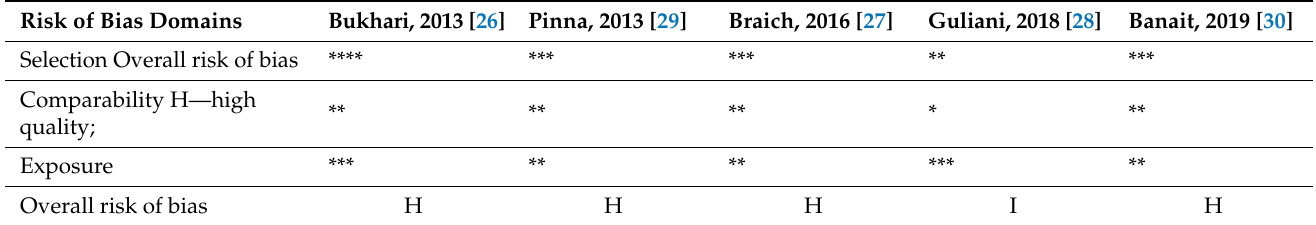
Table 3. Quality of evidence assessment for the papers in the meta-analysis.